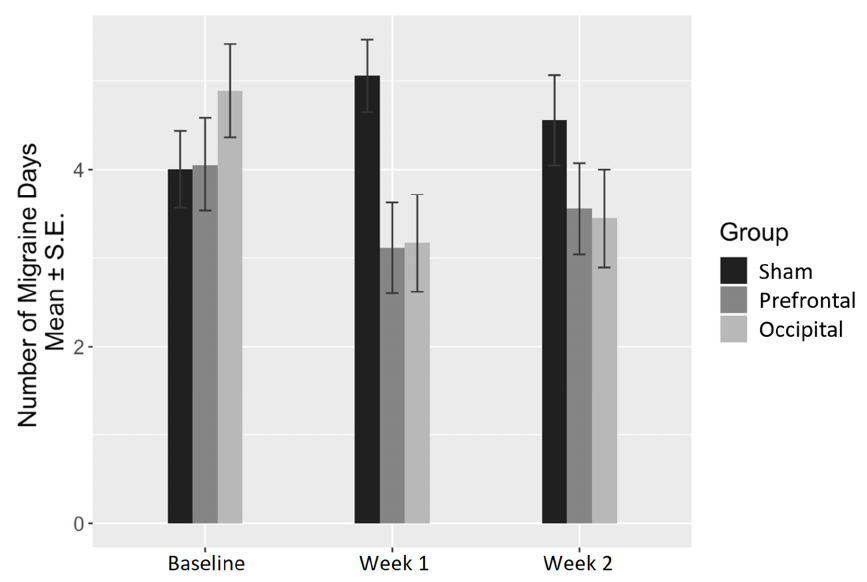
Figure 3. Change in the number of migraine days per